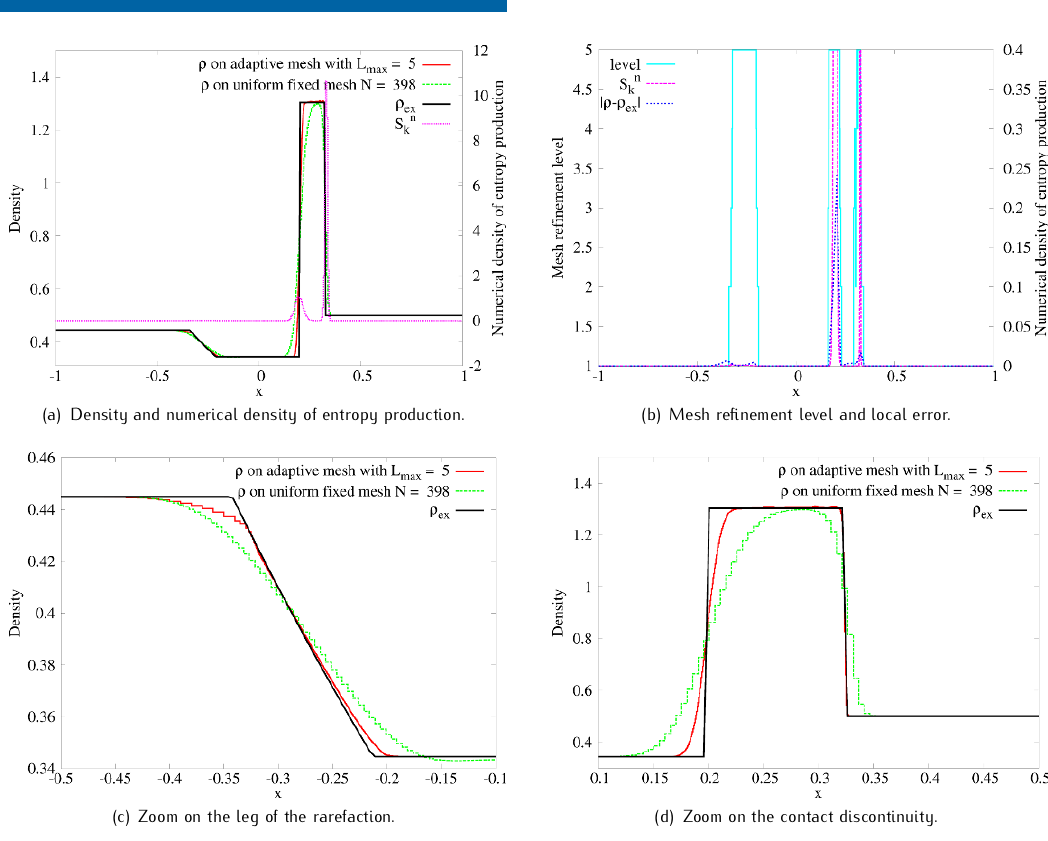
Figure 10. Lax’s shock tube problem: solution at time t = 0 . 13 using the AB1M scheme with L